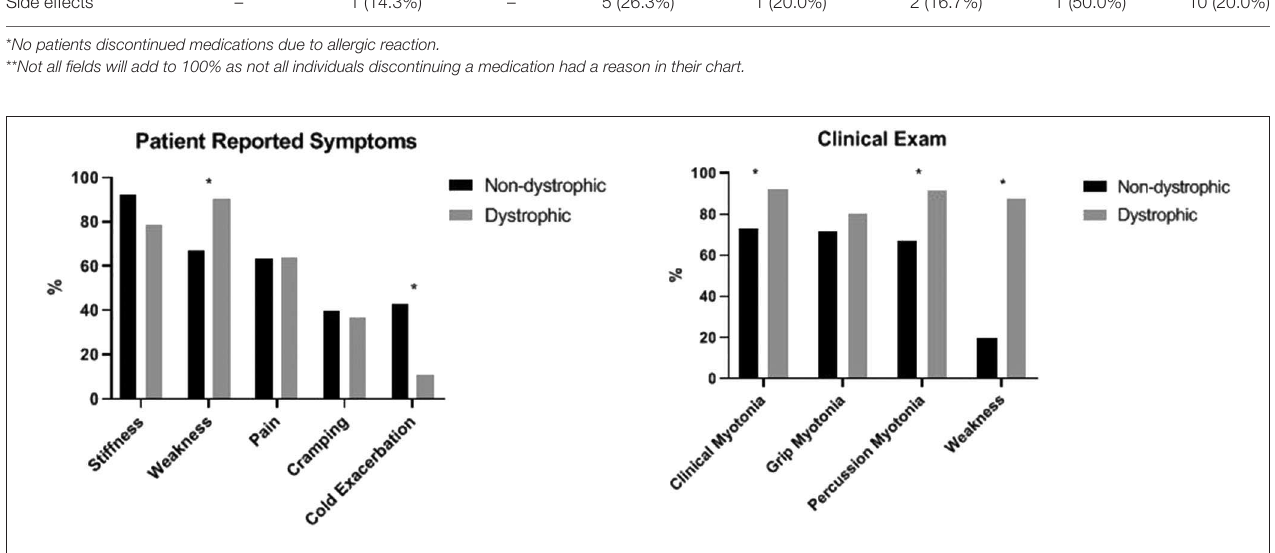
FIGURE 5 | Comparison of patient reported symptoms and clinical examination between patients with non-dystrophic myotonia and dystrophic myotonia. Asterisks indicate areas with statistically significant differences. Clinical myotonia ( p = 0.0073), percussion myotonia ( p = 0.0051), and muscle weakness ( p < 0.0001) were